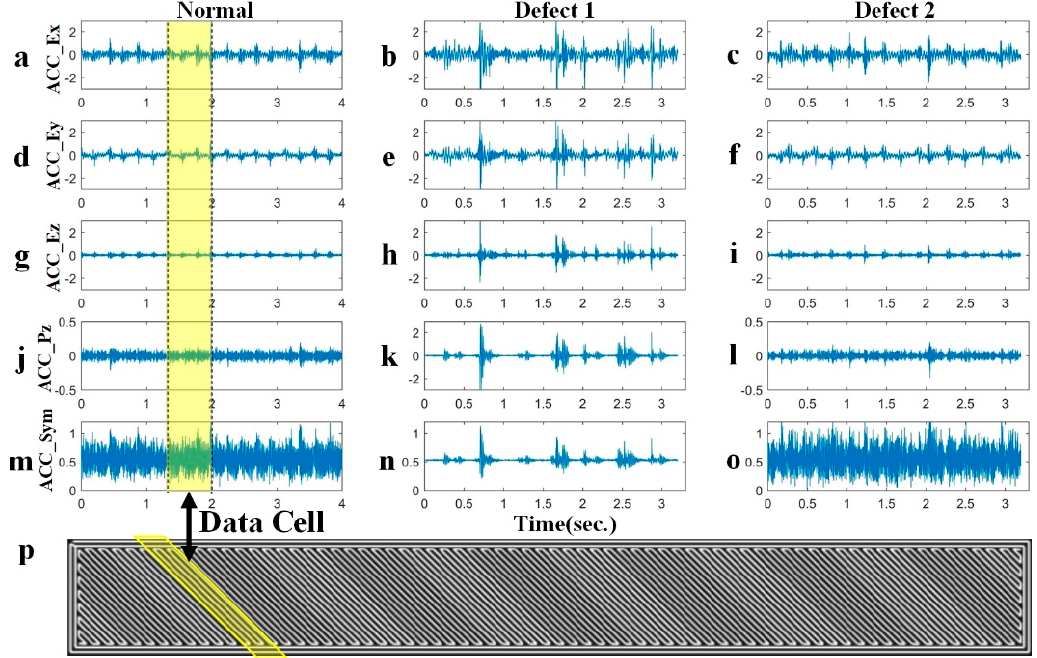
Figure 8. The acceleration signals: ( a )–( c ) x direction of the extruder; ( d )–( f ) y direction of the extruder; ( g )–( i ) z direction of the extruder; ( j )–( l ) z direction of the build platform; ( m )–( o ) synthetic acceleration; ( p ) the basic working condition and the yellow zone stands for the data cell.